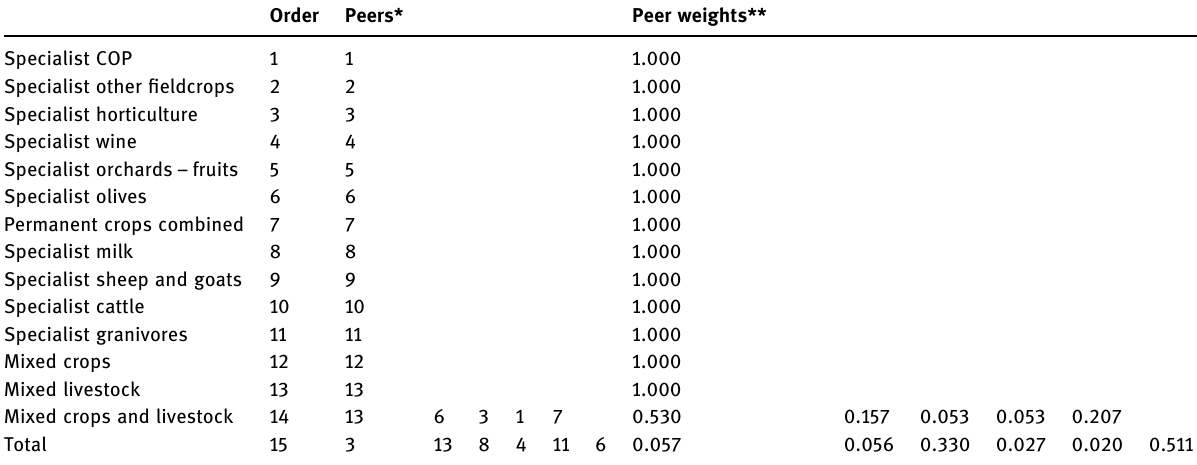
Table 6: Peer and peer weights ( obtained through input orientated DEA and using multi - stage method ) for the several EU farm types ( data on average for the period 2014 – 2018 ) , considering the subsidies as additional